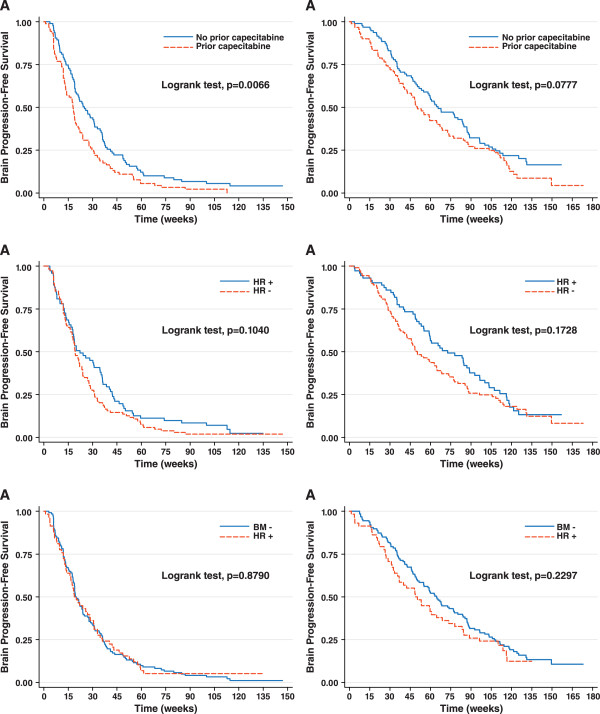
In the overall population regardless of brain metastasis status, Kaplan-Meier estimates for (A) PFS by prior capecitabine; (B) OS by prior capecitabine; (C) PFS by hormone receptor (HR) status; (D) OS by HR status; (E) PFS by brain metastasis status in; (F) OS by brain metastasis status